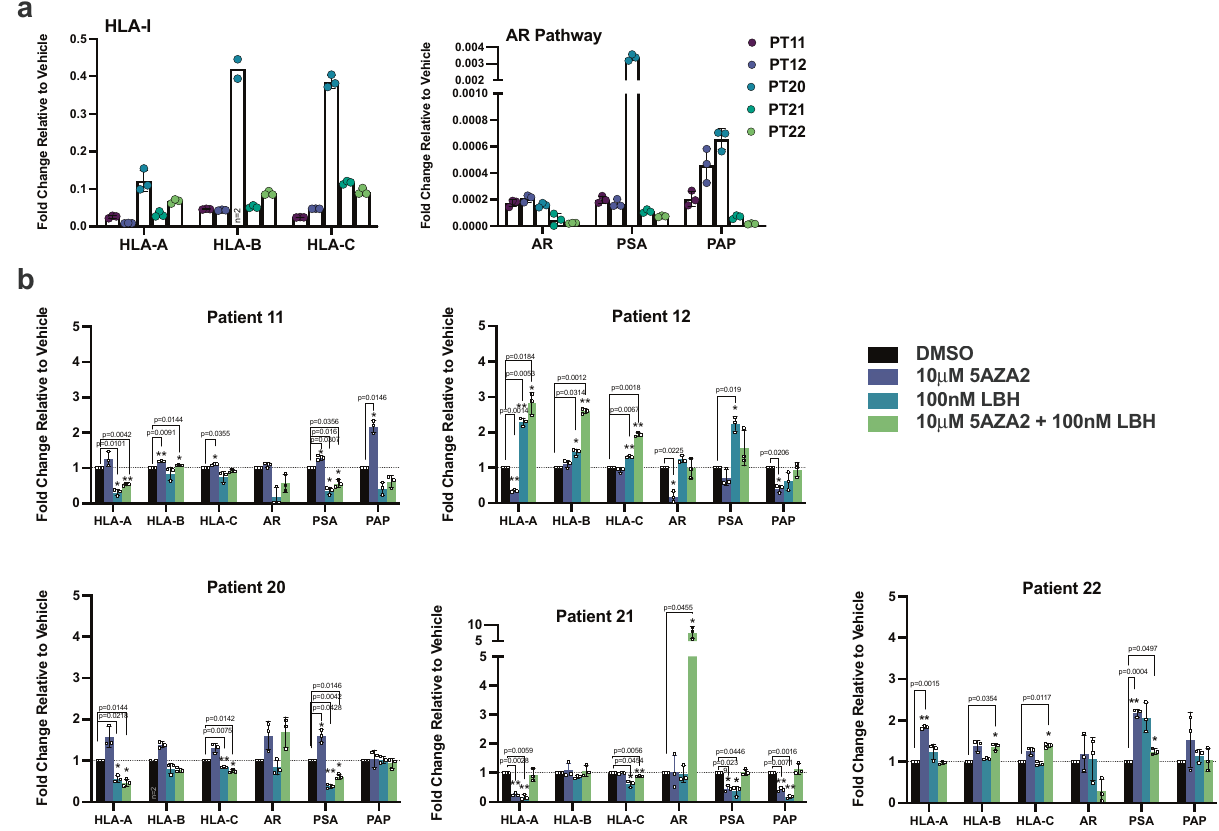
Fig. 5 HLA-I expression and response to DNMT and HDAC inhibition ex vivo. a Gene expression analysis of the HLA-I genes and prostate-speci fi c elements of the AR pathway in prostate tumor tissue cultured ex vivo. b Gene expression analysis of induction of HLA-I and AR pathway elements in ex vivo tissue treated with DMSO, 5AZA2, LBH, or 5AZA2 + LBH; n = 3. Error bars represent